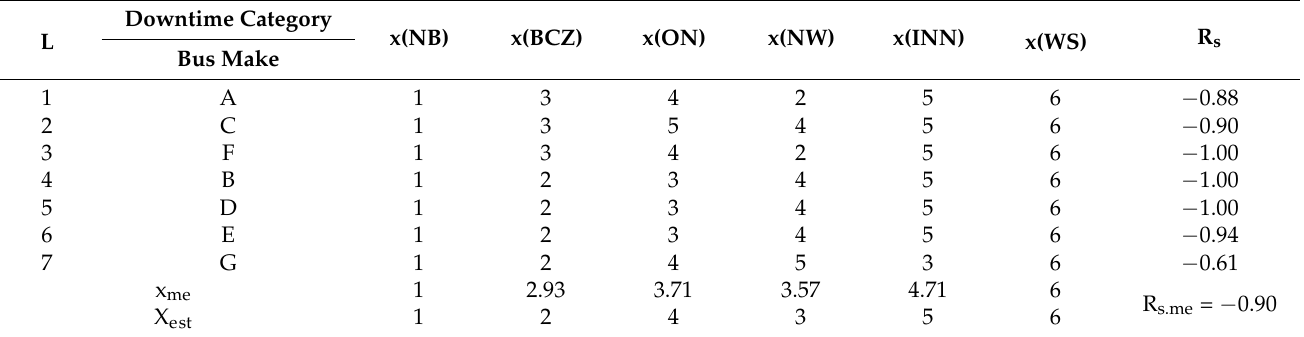
Table 4. Downtime ranks and Spearman’s rank correlation coefficient between categorized unavail- ability and downtime